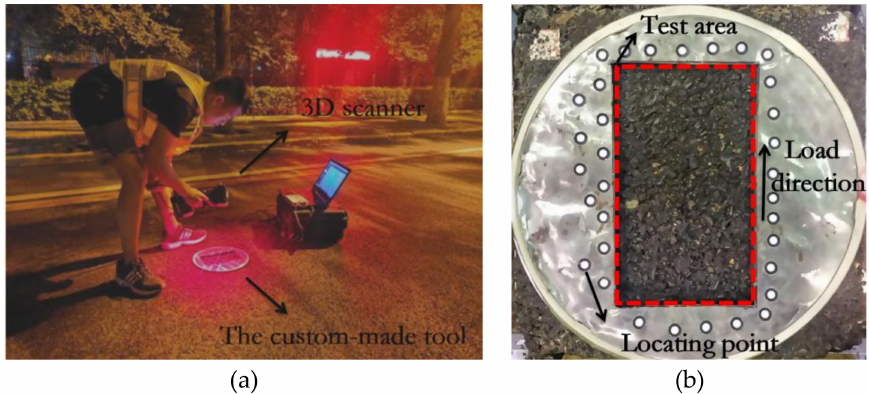
Figure 3. The three-dimensional (3D) surface topography acquisition process. ( a ) Field setup. ( b ) Laboratory setup for the rutting